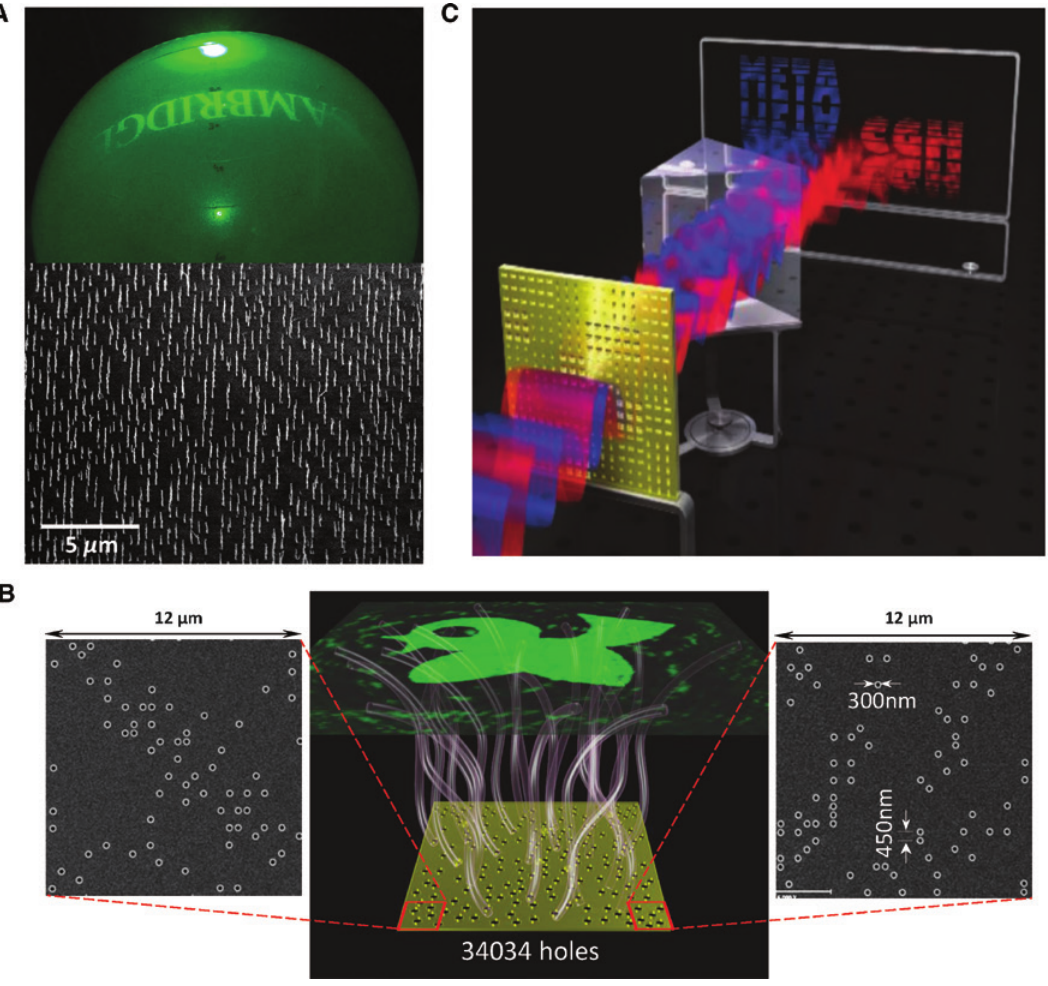
Figure 3: Amplitude-only metasurface holography. (A) Reconstructed binary amplitude hologram (top) by using carbon nanotubes (bottom) [66]; (B) binary amplitude hologram by using a randomly patterned photon sieve [29]; (C) schematic of a metasurface hologram with the nanoaperture arrays perforated in a metal film with binary amplitude modulations at two wavelengths [67]. Reprint permission obtained from [29, 66,